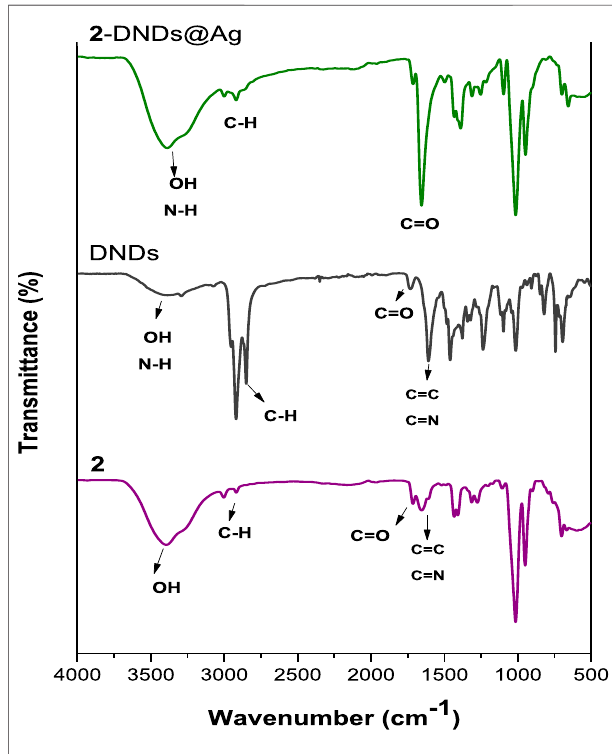
FIGURE 3 | The FT-IR spectra of 2 , DNDs, 2 -DNDs@Ag (used as an example).